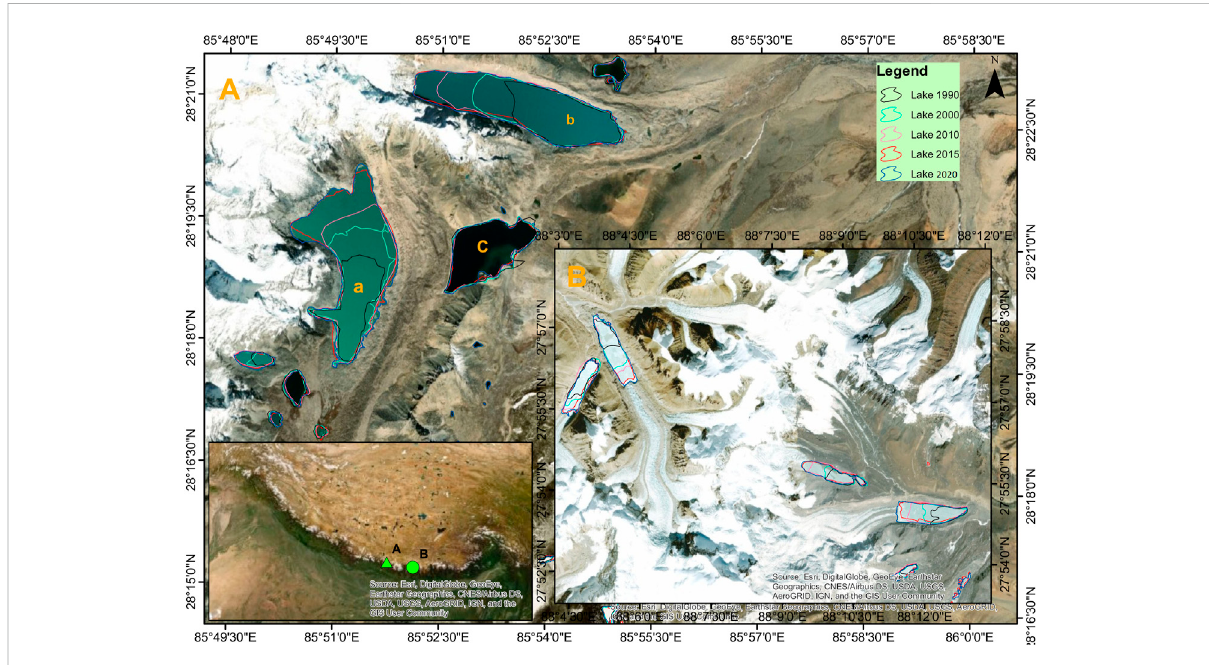
FIGURE 7 Thegrowth processofproglacial lakesisshown. Figure (A) showsproglacial lakes (A,B) became connectedtounconnectedwithtime,whereas in fi gure (B) , these proglacial lakes are remained